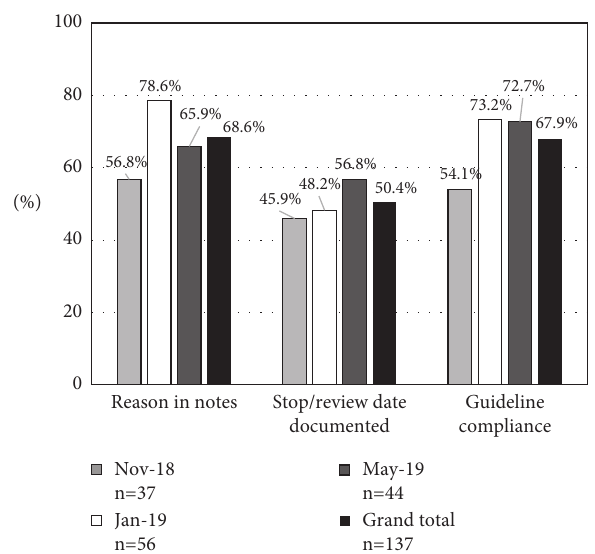
Figure 3: Quality indicators for antimicrobial prescriptions during three survey periods in November 2018, January 2019, and May 2019 at the Maruki Memorial Welfare and Medical Center,